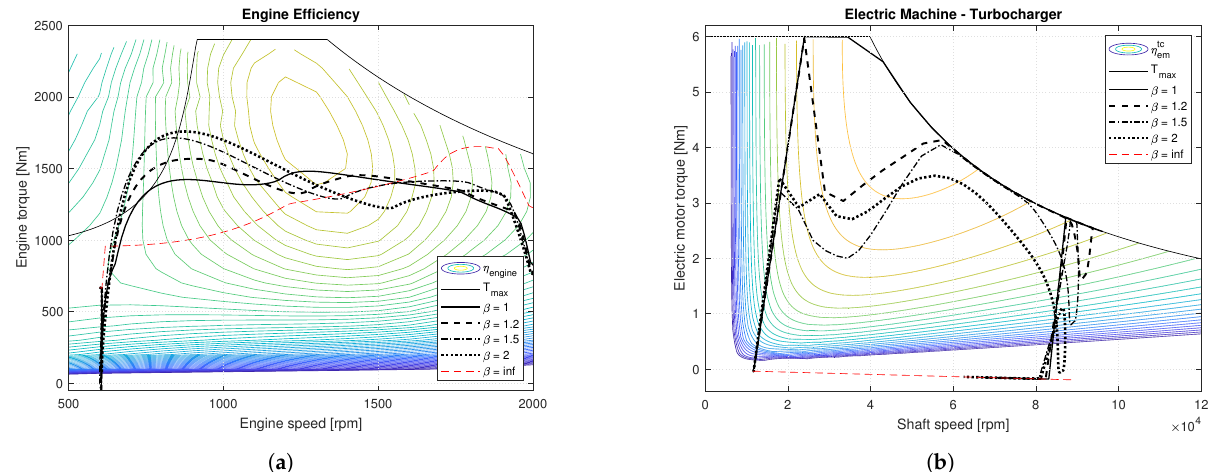
Figure 7. Solution characteristics when using a combustion engine and a turbocharged electric motor. The legends display the cost factors ( β ) for the different solutions. ( a ) Diesel engine utilization during an energy-optimal acceleration with E-turbo. ( b ) Utilization of the E-turbo during the acceleration. When β = inf, the electric motor torque is negative due to